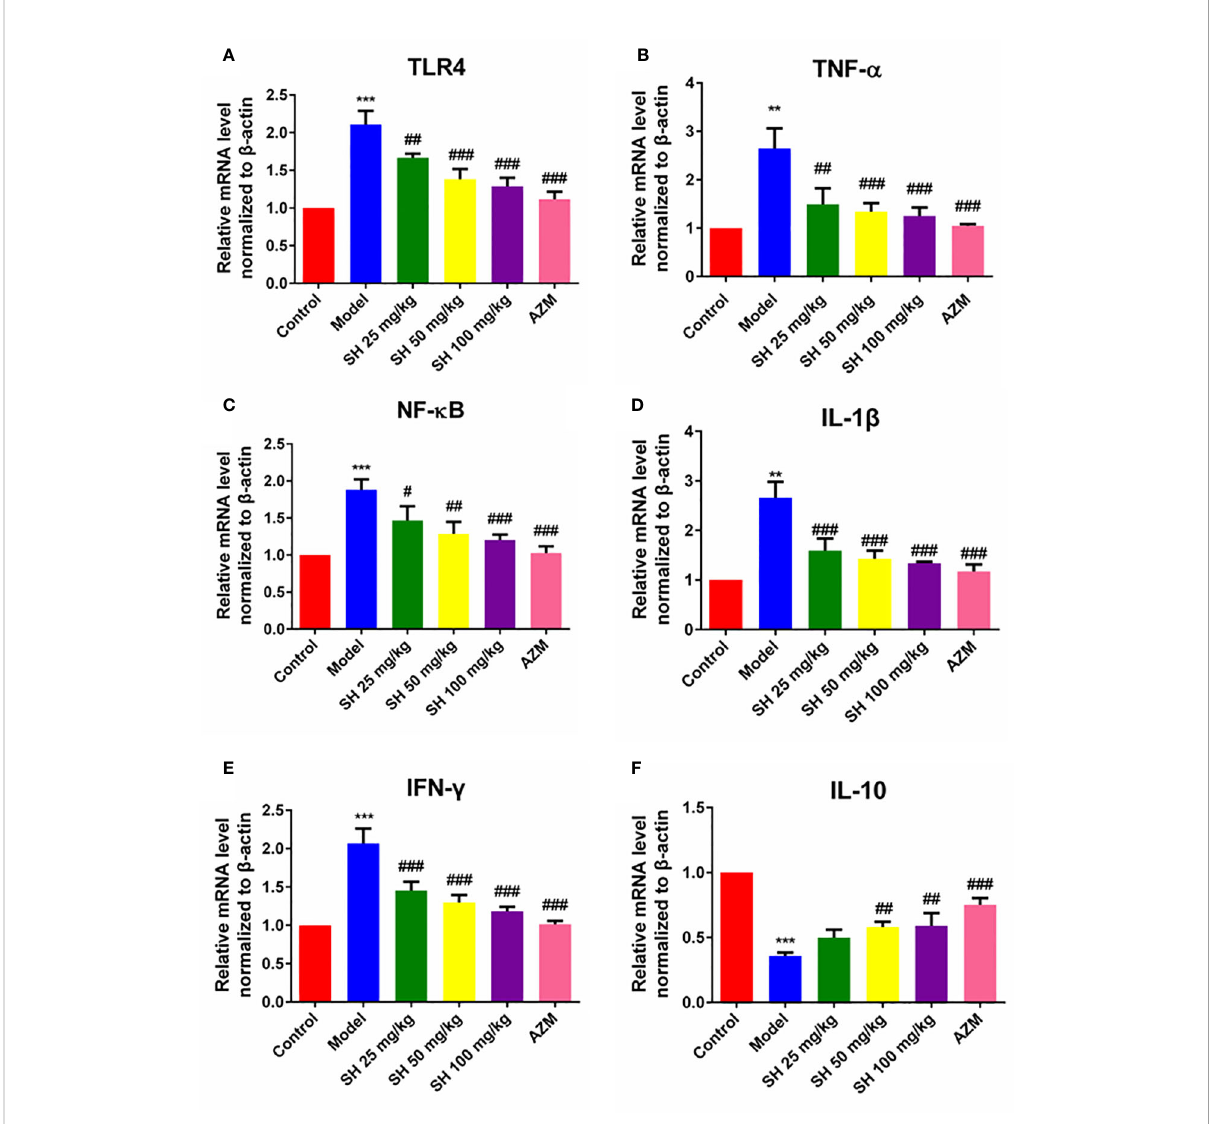
FIGURE 3 The expression of in fl ammatory genes in pneumonia mice after SH treatment. (A) TLR4 . (B) TNF- a . (C) NF- k B . (D) IL-1 b . (E) IFN- g . (F) IL-10 . Data are represented as mean ± SD (n=6). **P<0.01 and ***P<0.001 mean signi fi cance of model group compared with control group. # P<0.05, ## P<0.01 and ### P<0.001 mean signi fi cance of drug treatments compared with the model